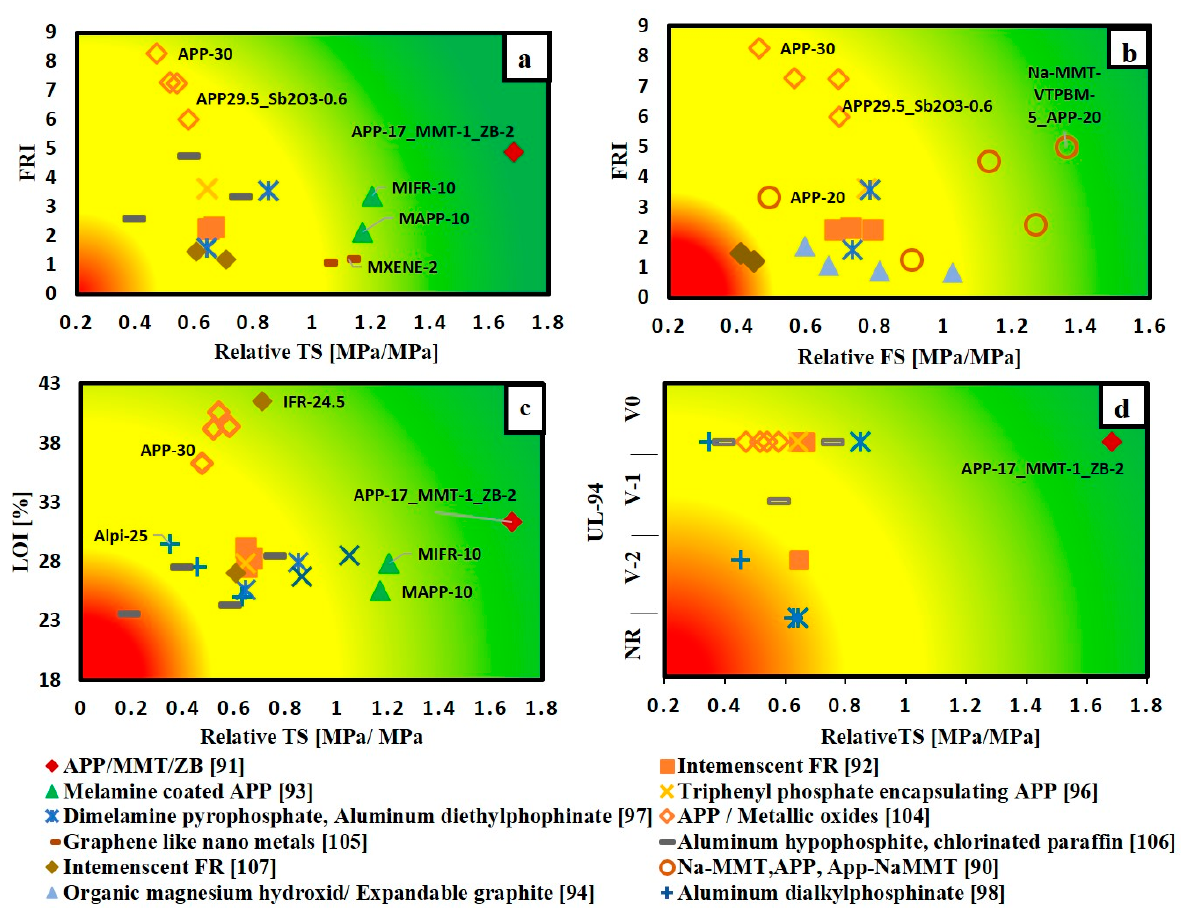
Figure 7. Selection chart of FR type regarding the desired flame retardance level and the relative mechanical property for unsaturated polyester resin ( a ) FRI versus relative TS; ( b ) FRI versus relative FS; ( c ) LOI% versus relative TS; ( d ) UL-94 versus relative TS.